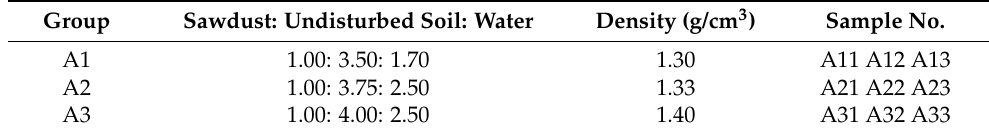
Table 1. Group A: sawdust + undisturbed soil (sawdust soil). Group